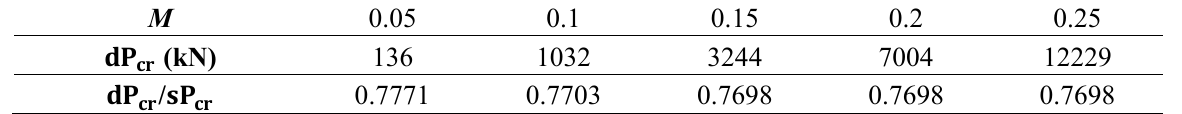
) ( h = 0.0). (cid:2913)(cid:2928)